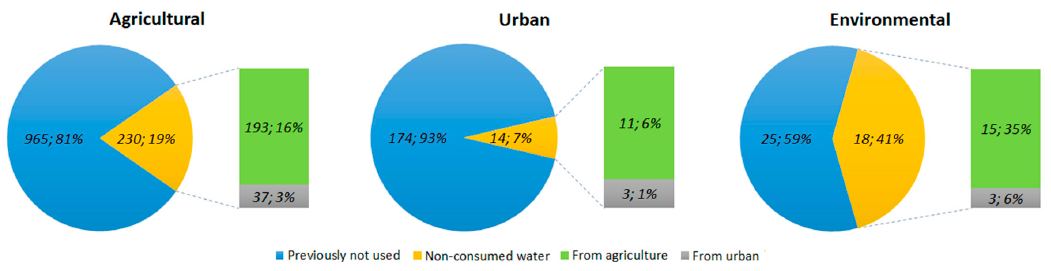
Figure 7. Sector-specific dependency on return flows and water not previously withdrawn (blue). Values are in hm 3 / year; percentages are relative to total water supply.